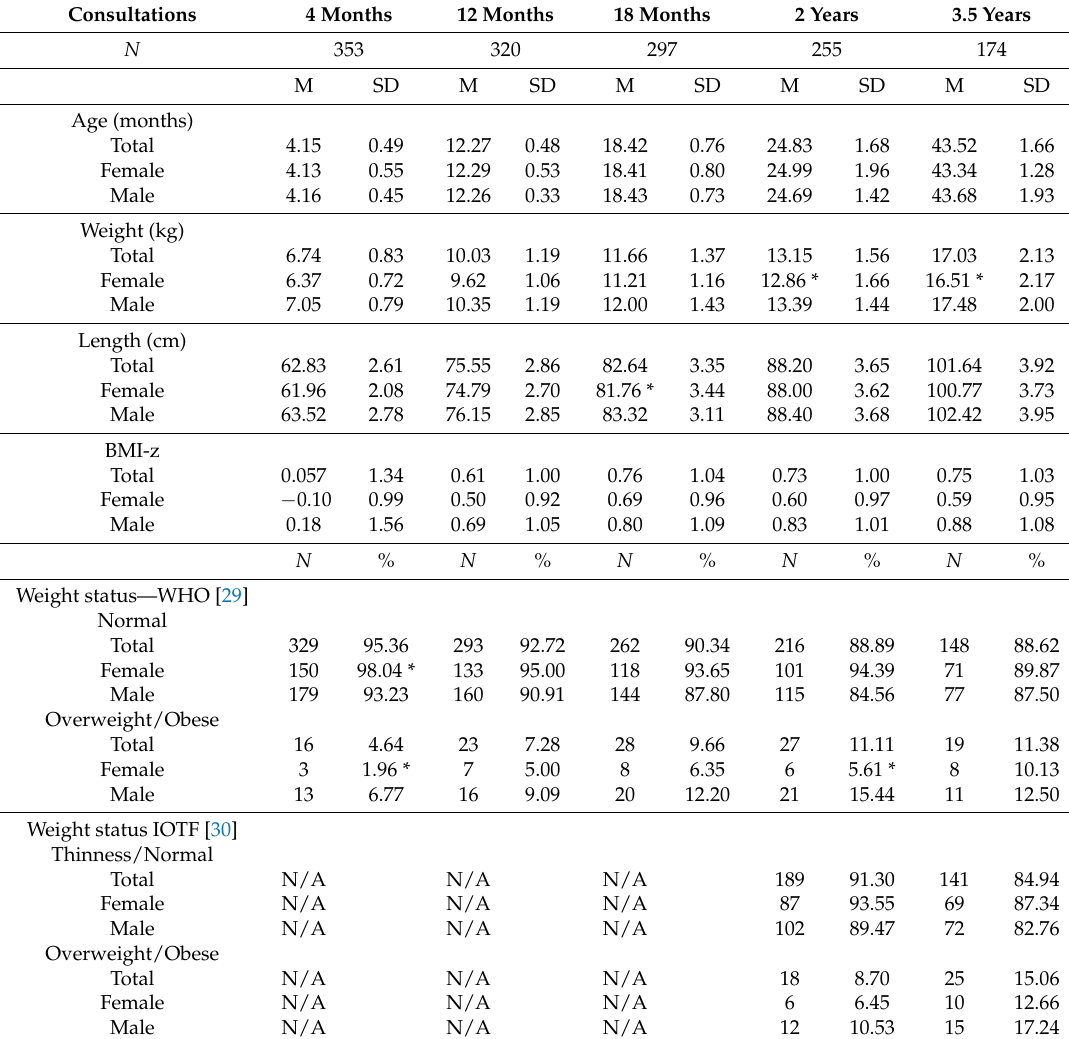
* indicates statistically different difference between sexes at p < 0.05. Abbreviations: MCH: Maternal Child and Health, N : number of children, M: mean, SD: standard deviation, WHO: World Health Organization, IOTF: International Obesity Task Force, BMI-z: body mass index z